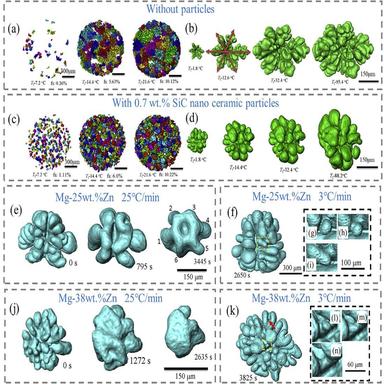
Dendritic evolution during coarsening of Mg alloys. (a–d) 3D grains and dendritic evolution in nanoparticle-free Mg-25 %Zn-7 %Al and nanoparticle SiC/Mg-25Zn-7Al during solidification at 12 °C min–1 ; (e–n) Dendritic evolution of α-Mg in Mg-25 % Zn and Mg-38 %Zn alloy during isothermal coarsening at 410 °C .